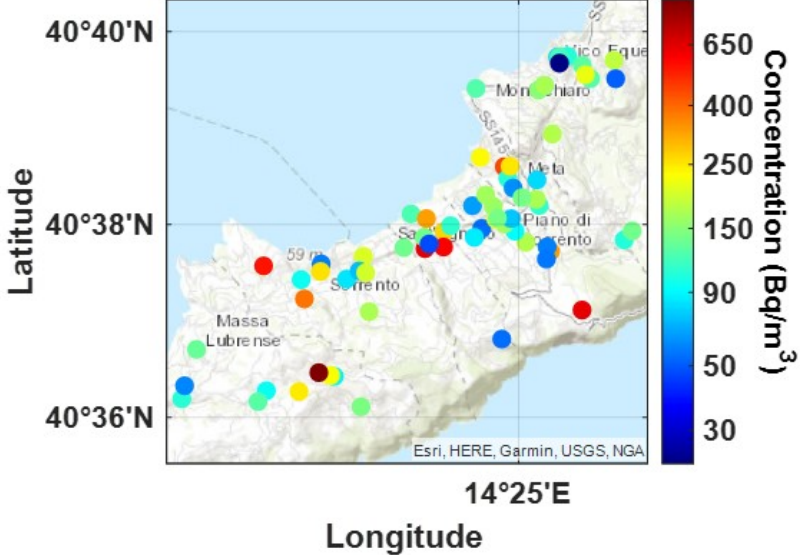
Figure 3. Indoor radon concentrations on the Sorrentina peninsula.